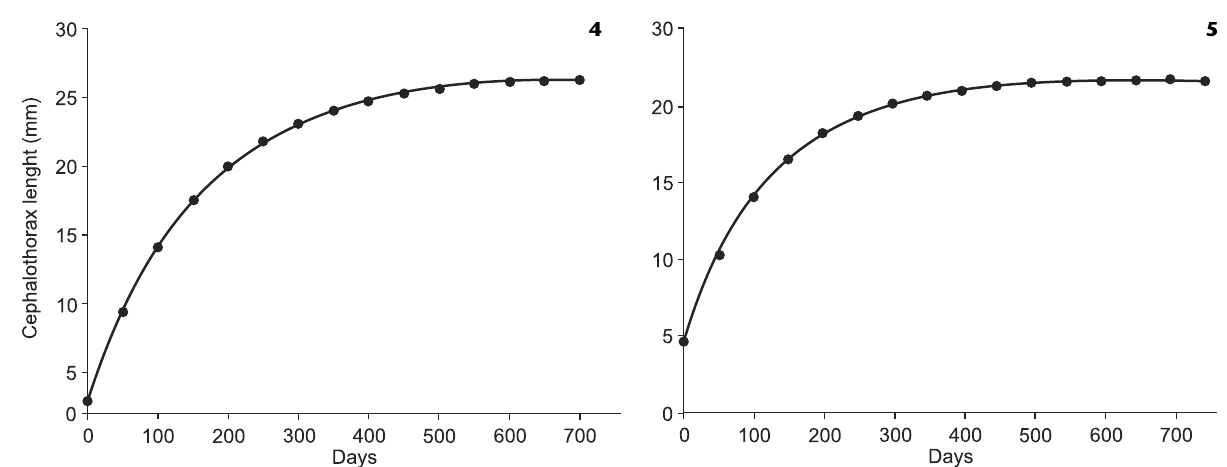
10Figures 4-5. Growth curve of cephalothoracic length (CL) (mm) in Aegla georginae males (4) and females (5), Perau Creek, Ibicuí Basin, Brazil. The following equations were fitted to the date: A: Ct = 26.57[1 – e -0.0064(t+18.14) (n = 1259; r = 0.93); B: Ct = 21.71[1 – e -0.008(t+30.25) (n = 512; r = 0.94). Where Ct = cephalothorax length in the time t; t = time in days.